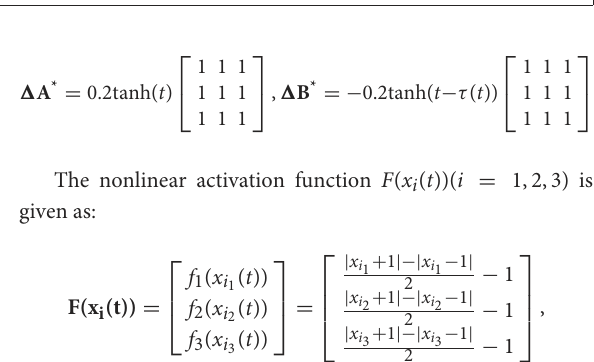
FIGURE9 The state trajectories produced by systems (8) and (9) under a self-triggered scheme (11). (A) The state curves of systems (8) and (9) with α (B) The synchronization errors ε ( t ) ε ( t ) y ( t ) x ( t = +